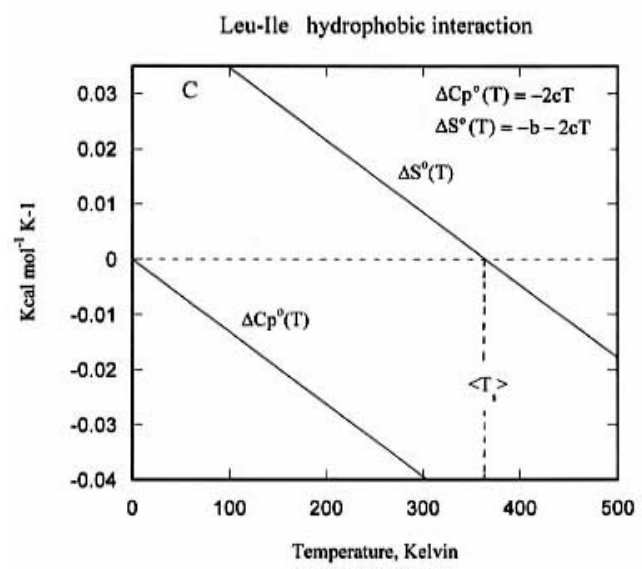
FIGURE 3B. Thermodynamic plot of Nemethy-Scheraga T 2 model for Leu-Ile hydrophobic interaction. Each data point between 0 and 500 K was evaluated with extrapolation of F-statistics[31,32]. The solid line represents fitted data, F = 0.0001, thus the goodness of fit of the experimental data was 99.99% or better in each case. The values for ∆ H o (T) and ∆ G o (T) determined from a linear T 2 polynomial function do not intercept at 0 K with zero slope and thus are inconsistent with Planck’s definition of the Nernst heat theorem[16].